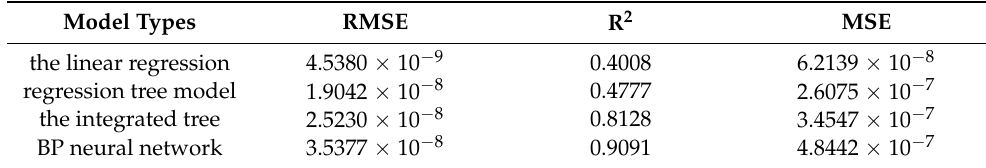
Table 3. Measuring point 1 ( z -axis) regression model evaluation parameters.